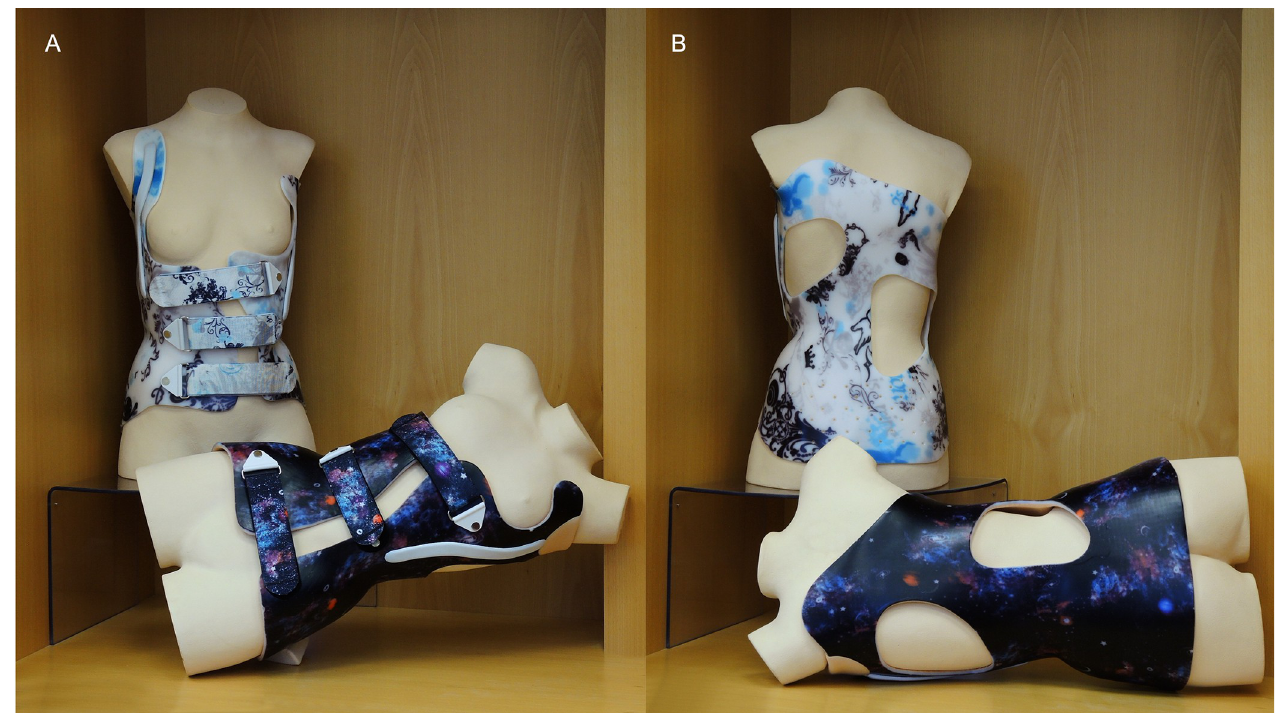
Fig 2. Exemplary presentation of a the Ch ê neau brace (upright position, to be worn at daytime) and the Charleston approach (horizontal position, to be worn at night) in front (A) and rear (B) view.